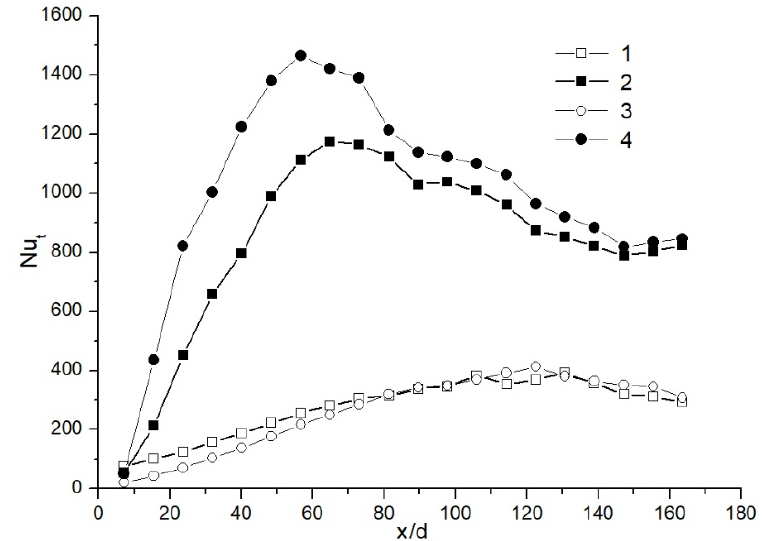
Figure 5. Distribution of the total local Nusselt number along the model of the condensing heat exchanger at Re in ≈ 21,000, different flue gas inlet temperatures and for the cases when no water was injected into the flue gas flow and when it was injected: (1) t in ≈ 97 °C without injection, (2) t in ≈ 97 °C with injection, (3) t in ≈ 129 °C without injection, (4) t in ≈ 135 °C with injection.